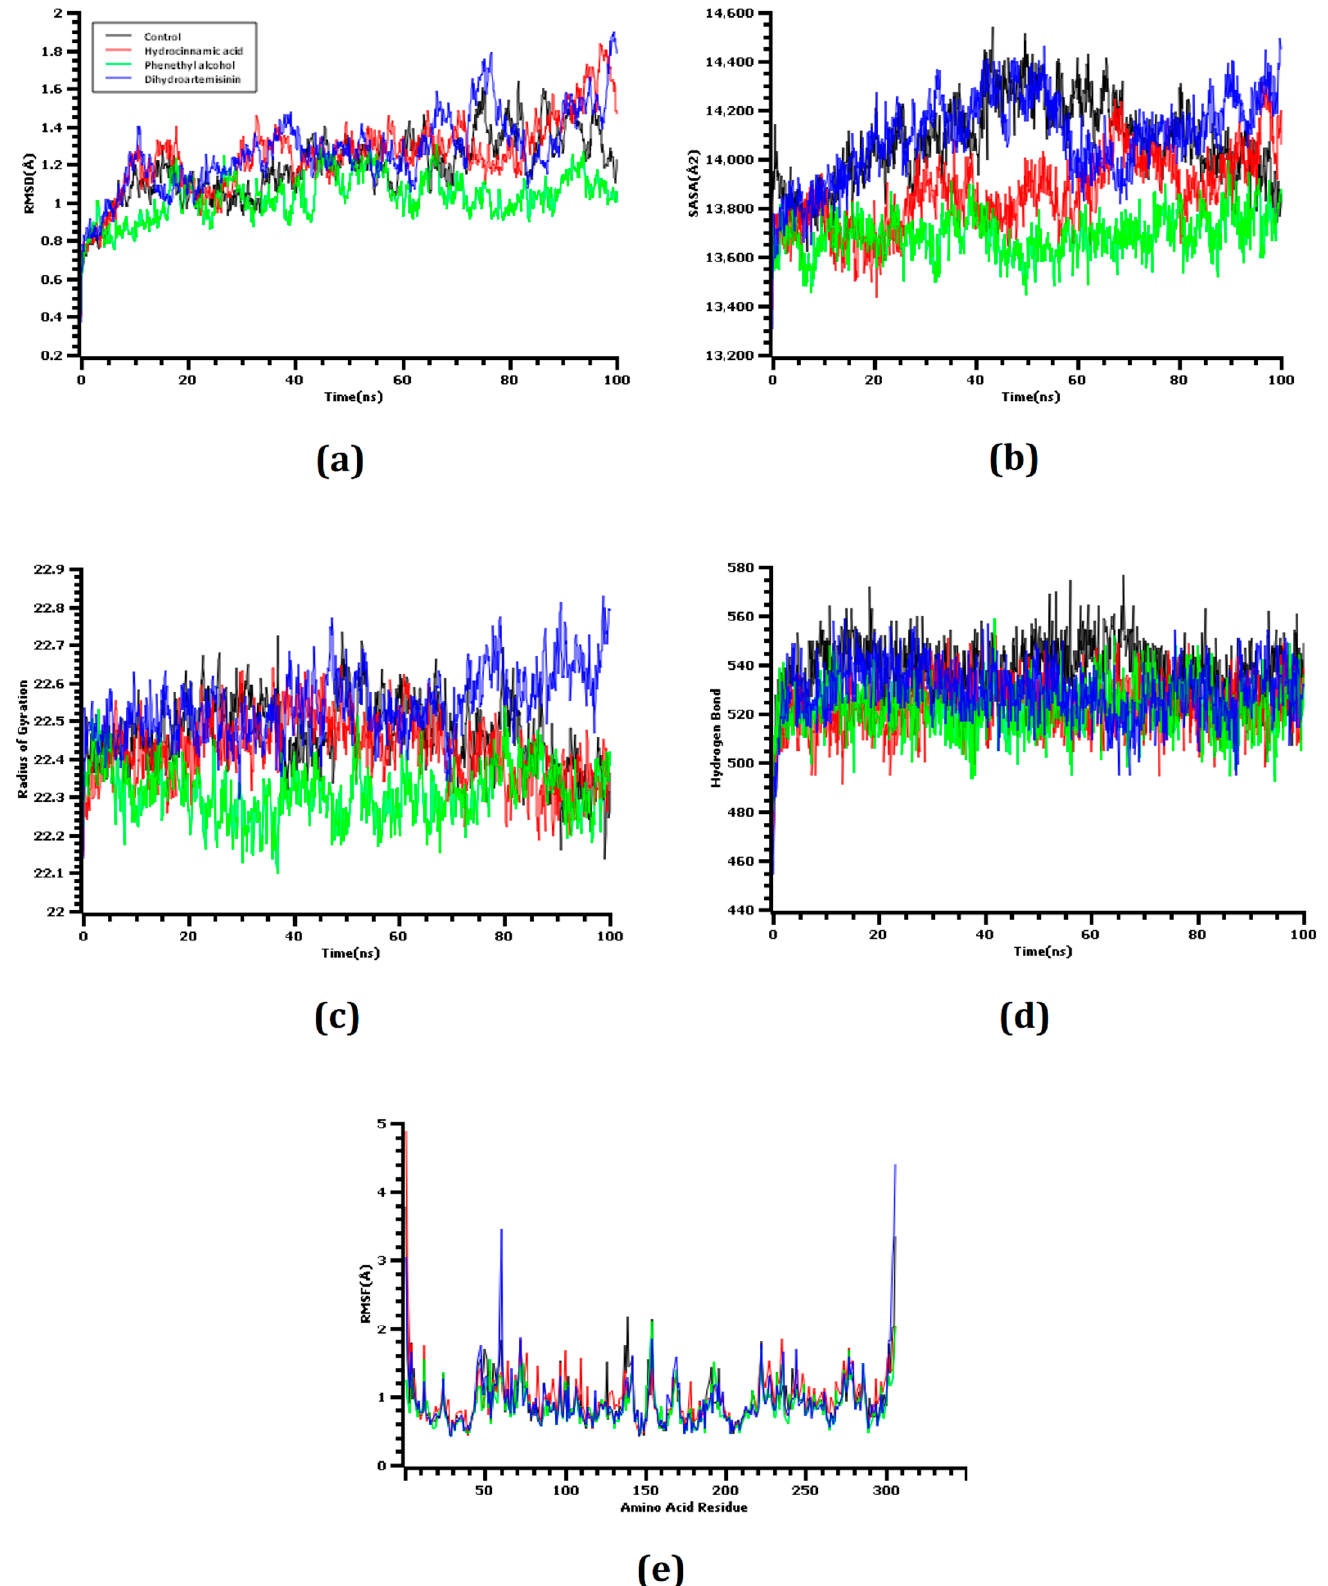
Figure 6. The molecular dynamics simulation. ( a ) Root mean square deviation of the control and four docked complexes, ( b ) solvent accessible surface area, ( c ) radius of gyration, ( d ) hydrogen bond of the docked and control complexes, and ( e ) root mean square fluctuation.